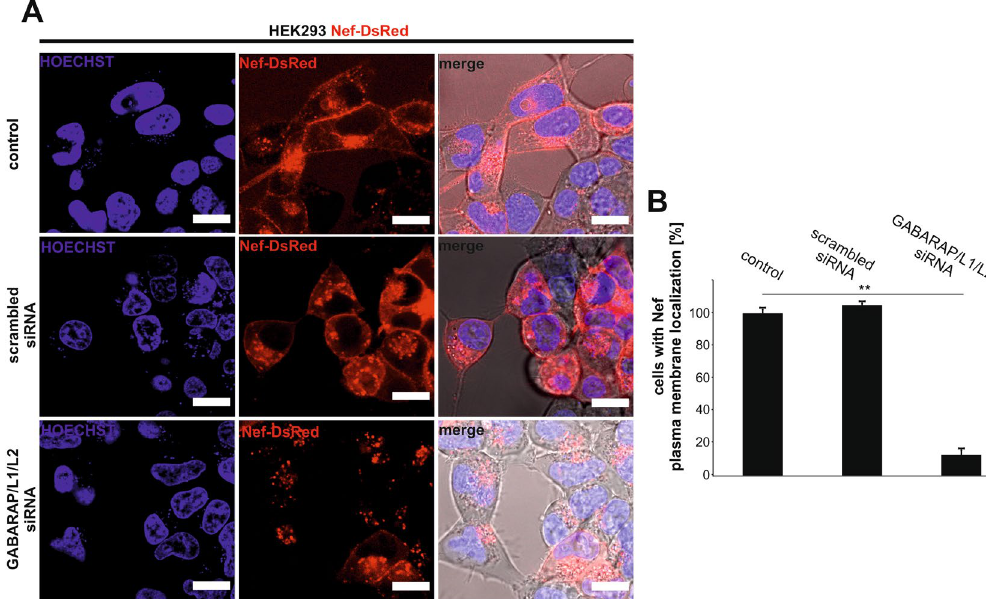
Figure 5. GABARAPs are required for plasma membrane localization of Nef. ( A ) Live-cell fluorescence microscopy of HEK293 cells stably expressing Nef-DsRed (red) and mock transfected as a control (top), transfected with scrambled siRNA (middle) or with a pool of GABARAP, -L1 and –L2 siRNAs (bottom). Hoechst 33442 was used to stain the nucleus (blue). Scale bar 20 µ m. ( B ) Quantification of cells with Nef plasma membrane localization after treatment with the respective siRNAs from three independent